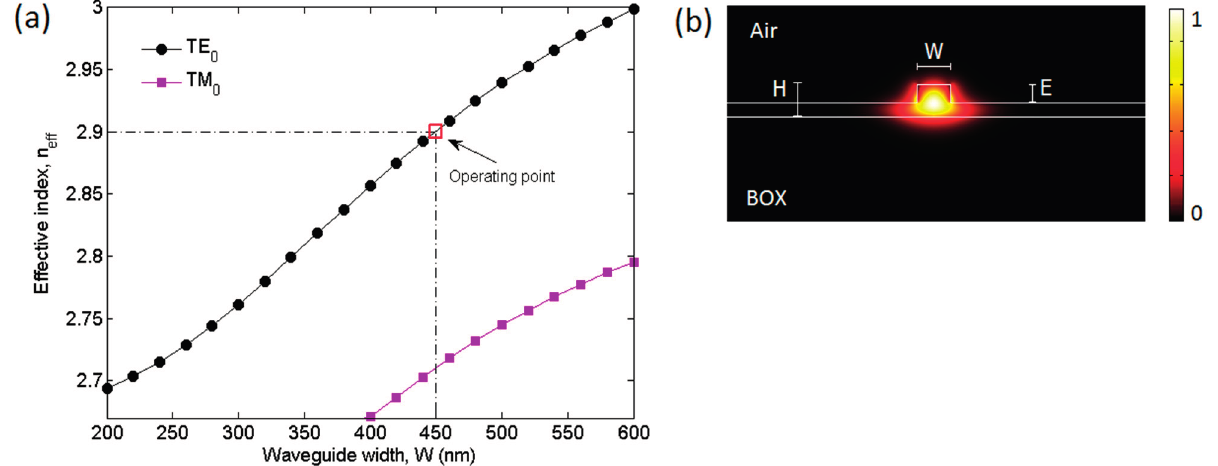
Figure 2. ( a ) Effective indexes of the fundamental quasi-TE and quasi-TM modes as a function of the waveguide width, W , with E = 220 nm and λ = 1.55 µm. The multimode optical mode spatial distribution in the SOI rib cut-off width is W ≈ 650 nm; ( b ) (cid:1831) (cid:3051) waveguide with nominal dimensions W = 450 nm, E = 220 nm operating at the NIR wavelength of 1.55 μ